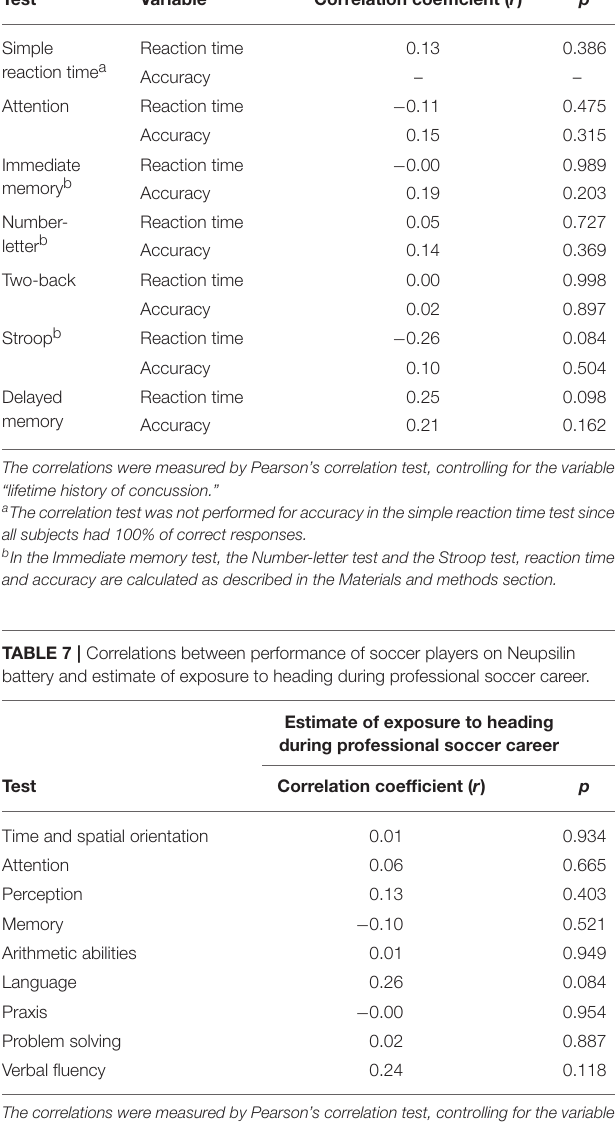
TABLE 8 | Comparison between soccer players with and without history of concussion on computerized cognitive assessment. p Soccer players with Soccer players history of without history of concussion ( n = 9)